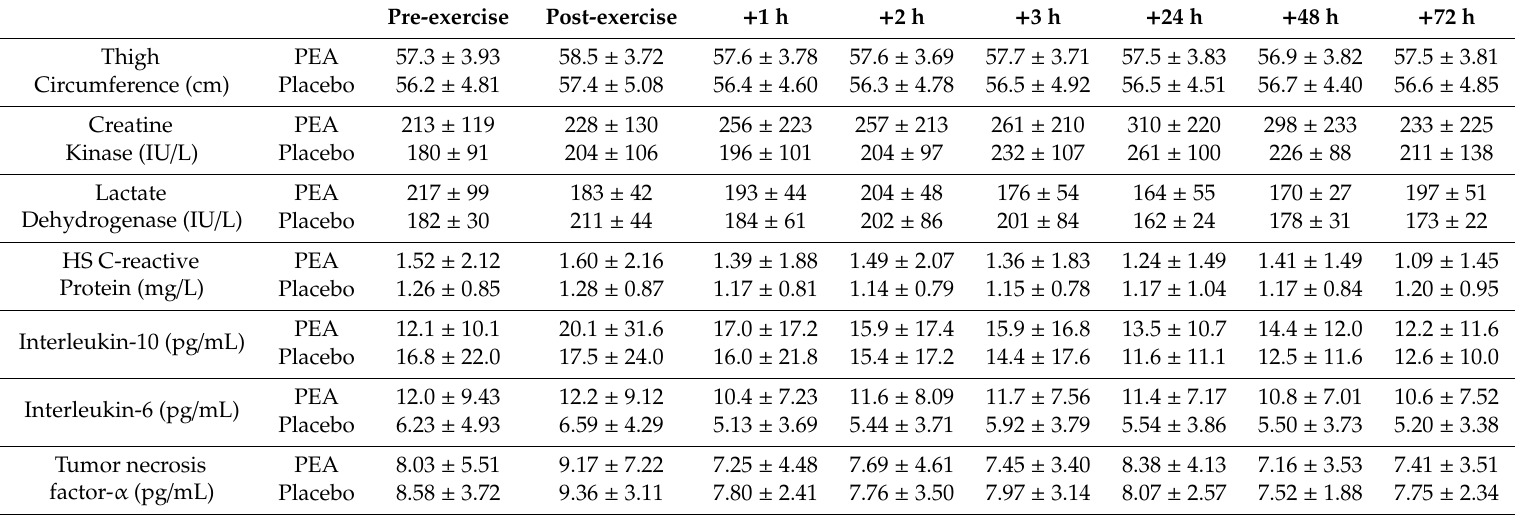
Table 3. Thigh circumference and biomarkers of muscle damage and inflammation for palmitoylethanolamide (PEA) and placebo groups. Values are mean ± SD.